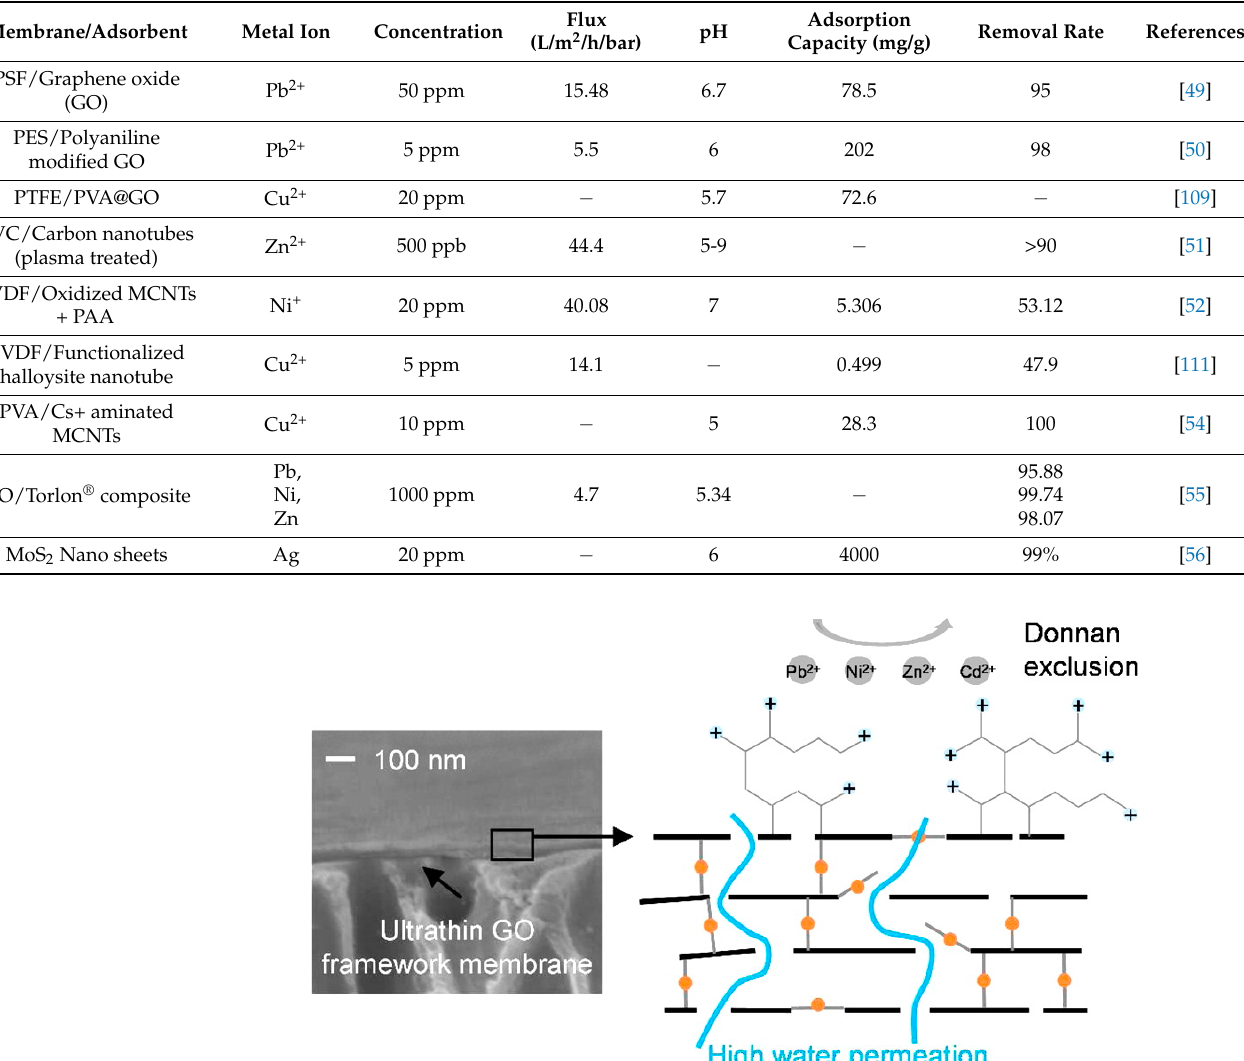
Table 3. Removal of heavy metals by 2DNMs membranes.